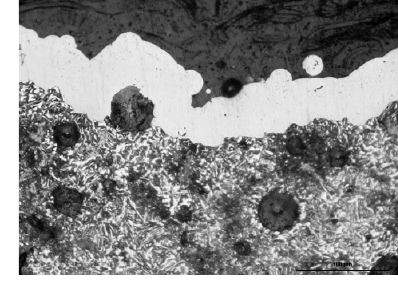
Figure 66: Austempered DCI (R = 0.1,  K = 20 MPa √ m).